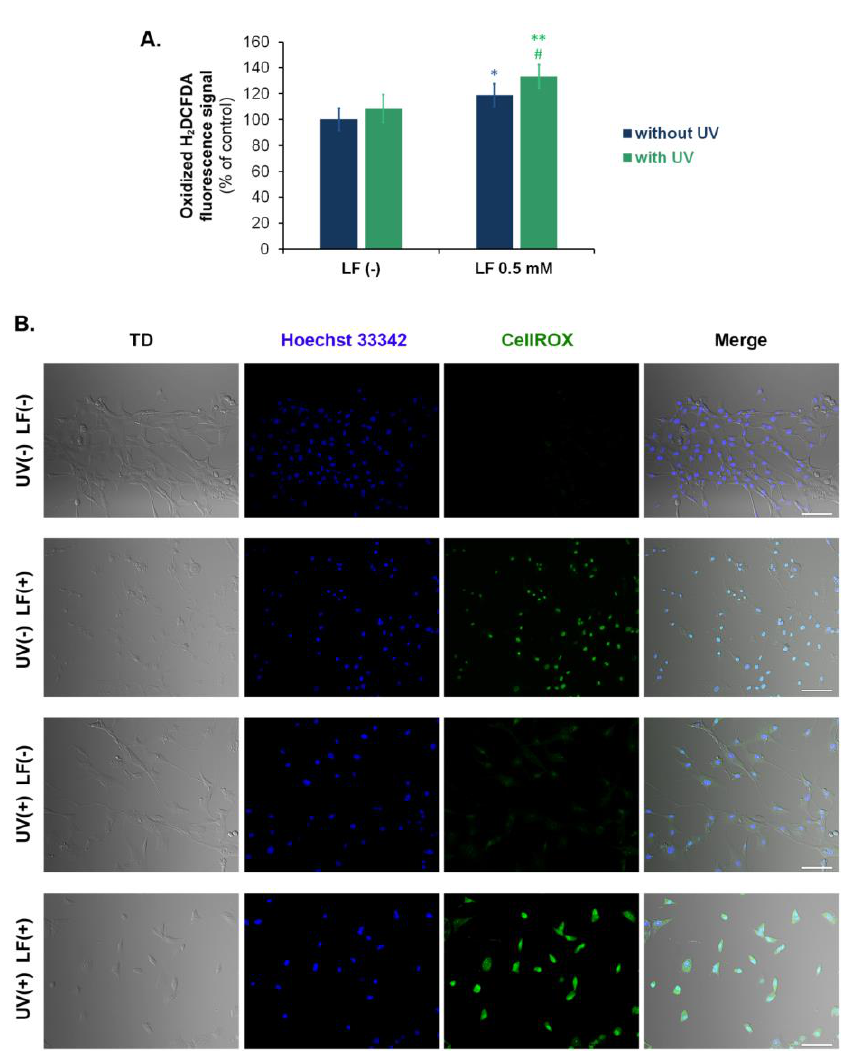
Figure 3. UVA radiation augments lomefloxacin-induced oxidative stress. Cells were exposed to lomefloxacin (LF) at a concentration of 0.5 mM and UVA radiation at a dose of 1.3 J/cm 2 . ( A ). Intra- cellular level of reactive oxygen species determined by H2DCFDA staining. Data are expressed as % of the controls. * p < 0.05, ** p < 0.01 vs. control; # p < 0.05 vs. non-treated cells exposed to UVA radiation. ( B ). Representative confocal microscopic images of fibroblasts stained with CellROX ® Green Reagent for oxidative stress detection (green channel) and Hoechst 33342 for nuclei visuali- zation (blue channel). Cell morphology was evaluated by observations using a transmitted light detector (TD). Scale bar = 100 µm.